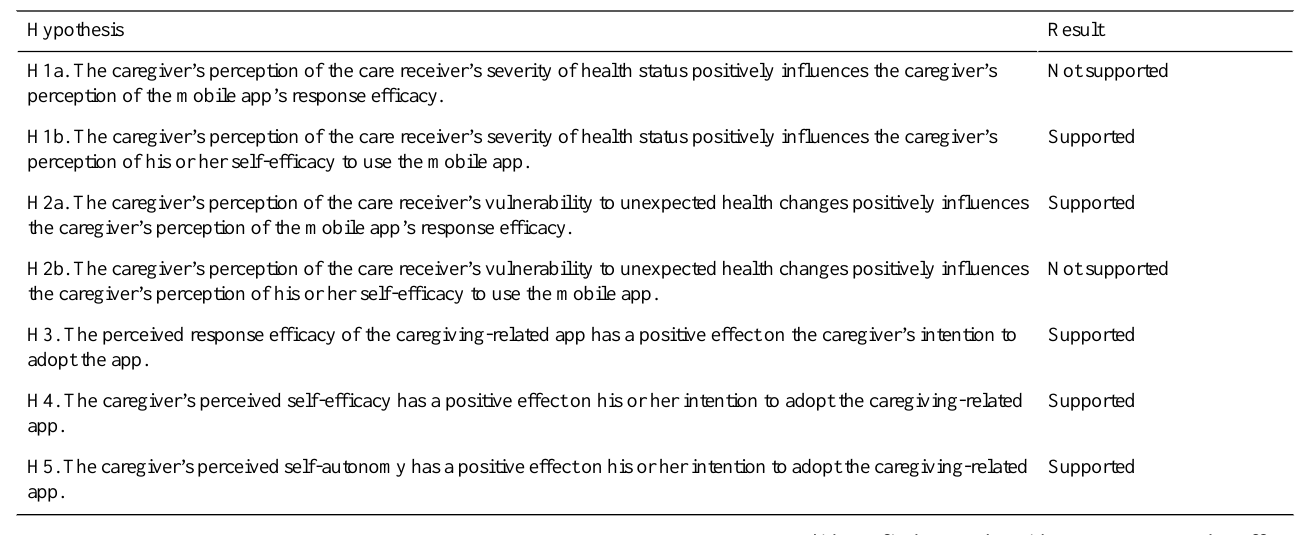
Table 7. Summary of